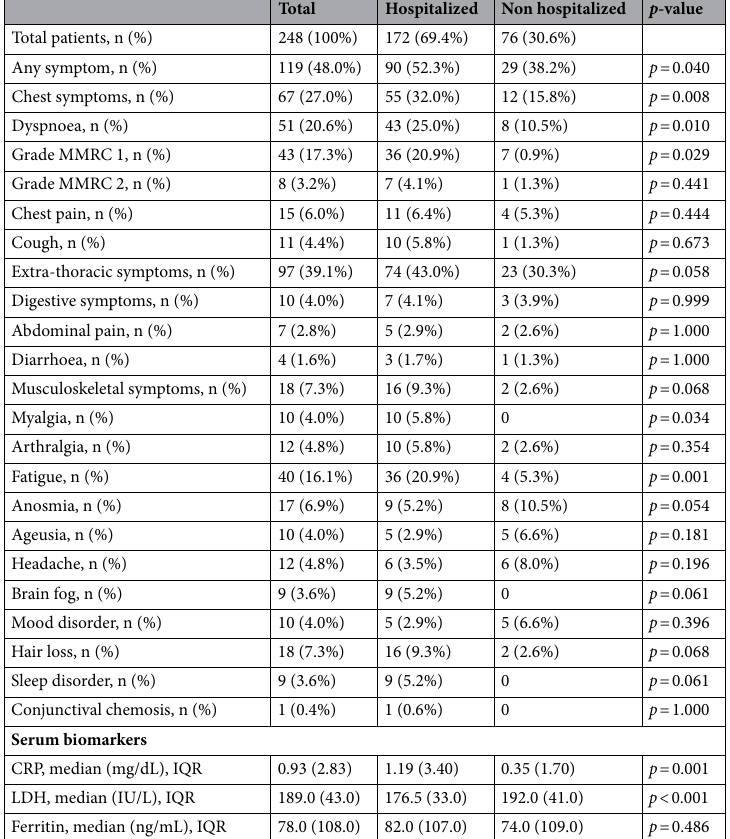
Table 2. Prevalence of 6 months persisting symptoms and serum biomarkers. CRP C-reactive protein, LDH lactate dehydrogenase, IQR interquartile range.